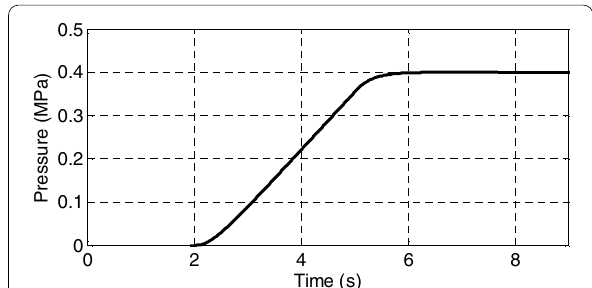
Figure 11 Pressure of air brake chamber under Condition 4